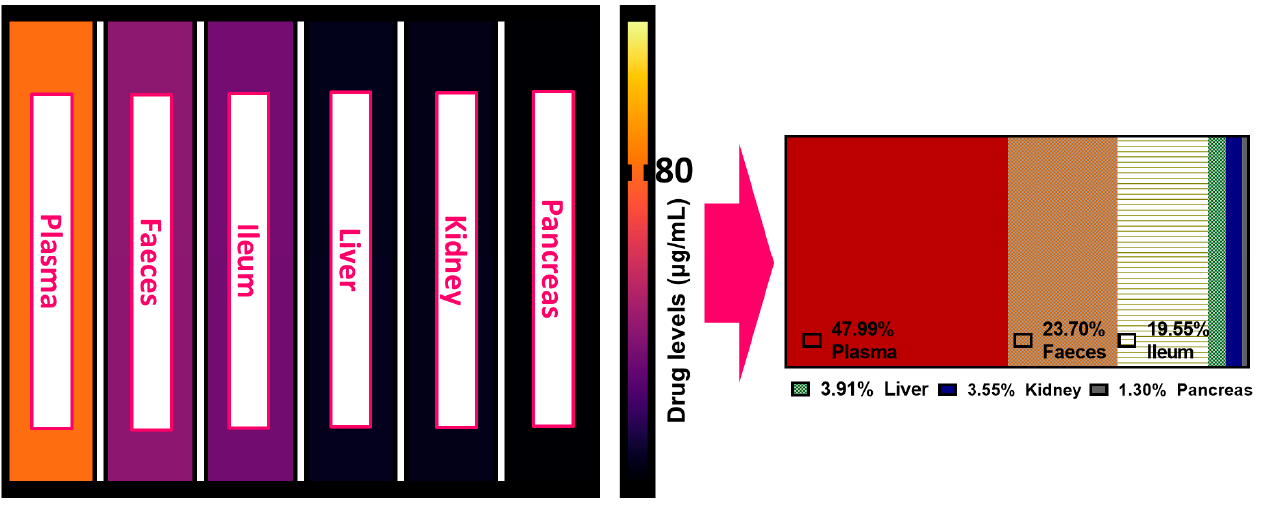
Figure 3. Metformin levels tested in the plasma, faeces, ileum, liver, kidney, and pancreas individually and as a ratio.